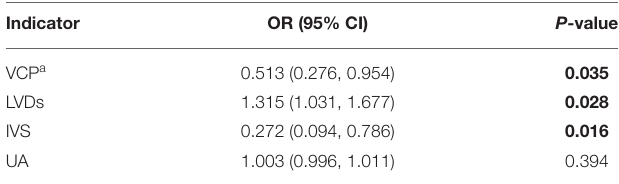
TABLE 5 | Risk factors for VD in patients with ACS evaluated by univariate logistic regression analysis (all indicators increases by 1 unit unless otherwise specified).